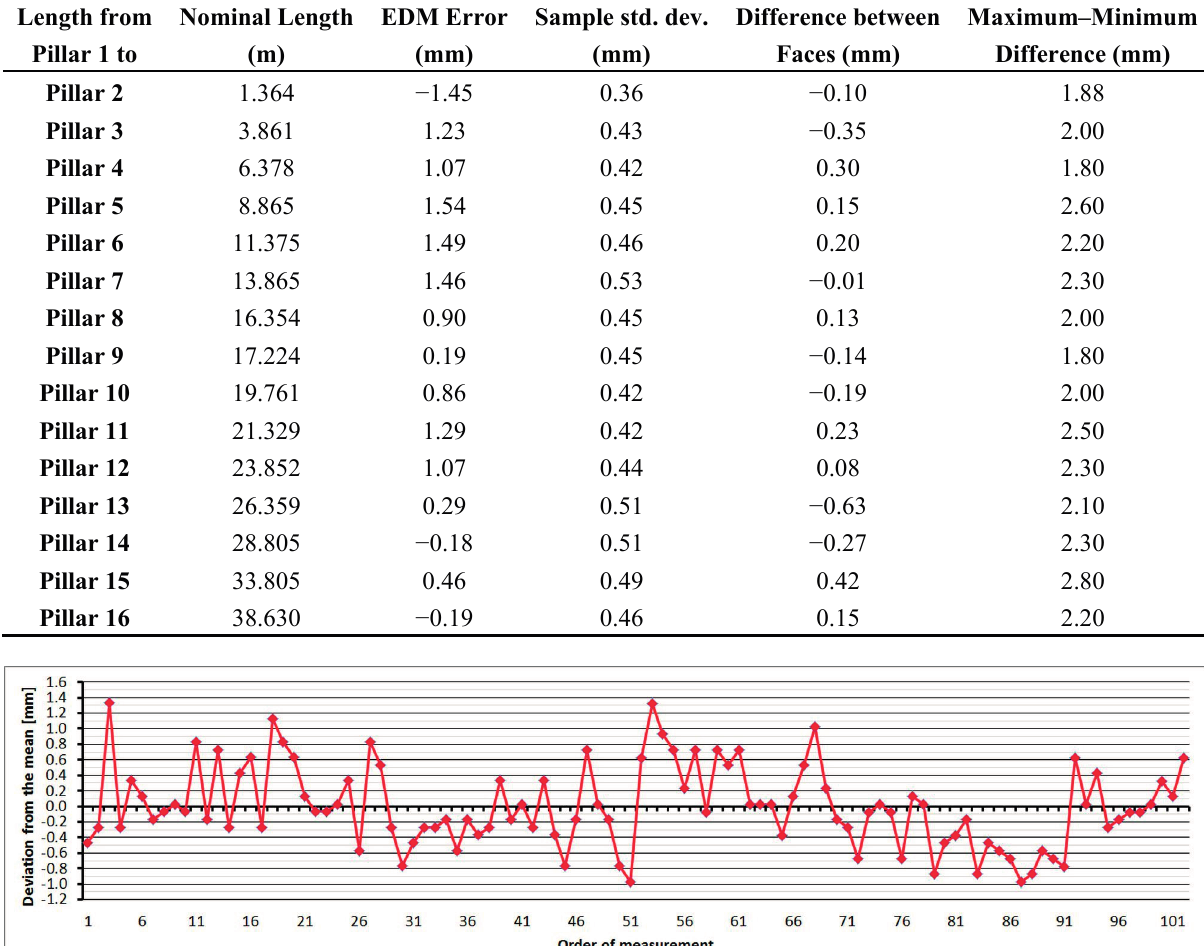
Figure 12. Trimble M3–Absolute errors in four epochs. Table 5. Trimble M3 (22 March 2014).